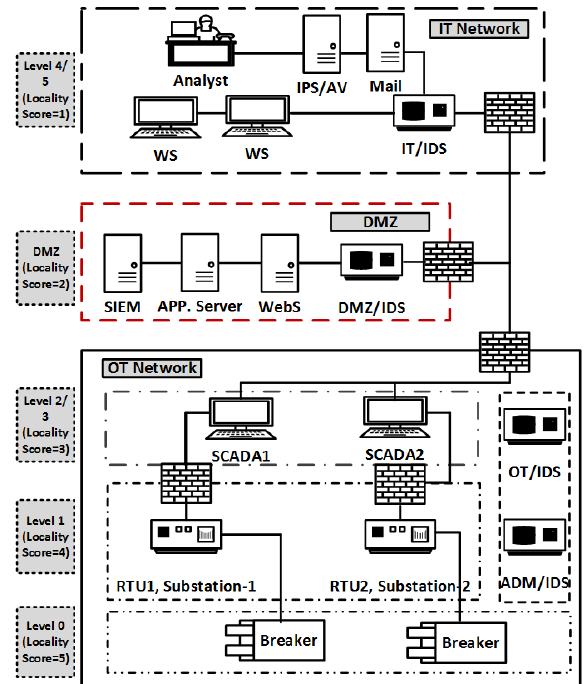
Figure 2. Logical view of EDS Test-bed